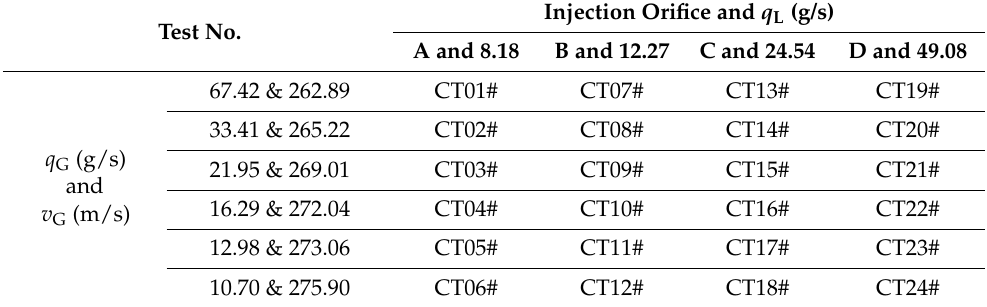
Table 1. Operating